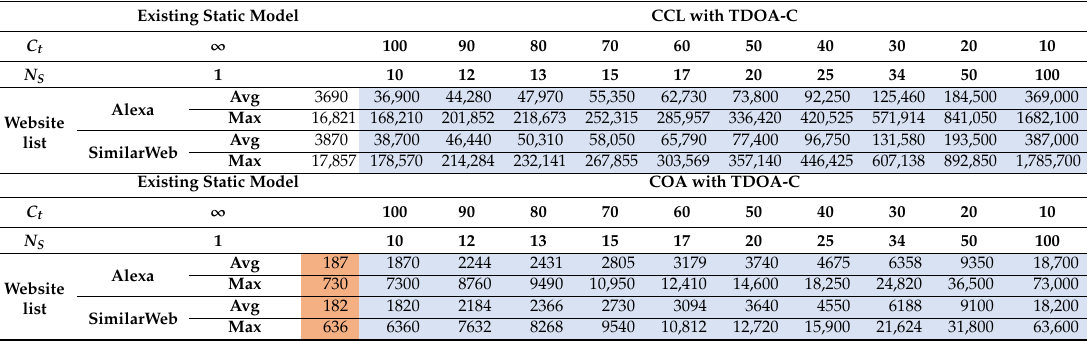
Table 3. The capacity of TDOA-C and existing static model with CCL and COA in 1000 s. The unit of capacity is bytes. 𝑁 𝑆 denotes the number of transmitted stego webpages. 𝐶 𝑡 denotes the cycle time that the period of a stego webpage is changed to the next stego webpage. CCL with